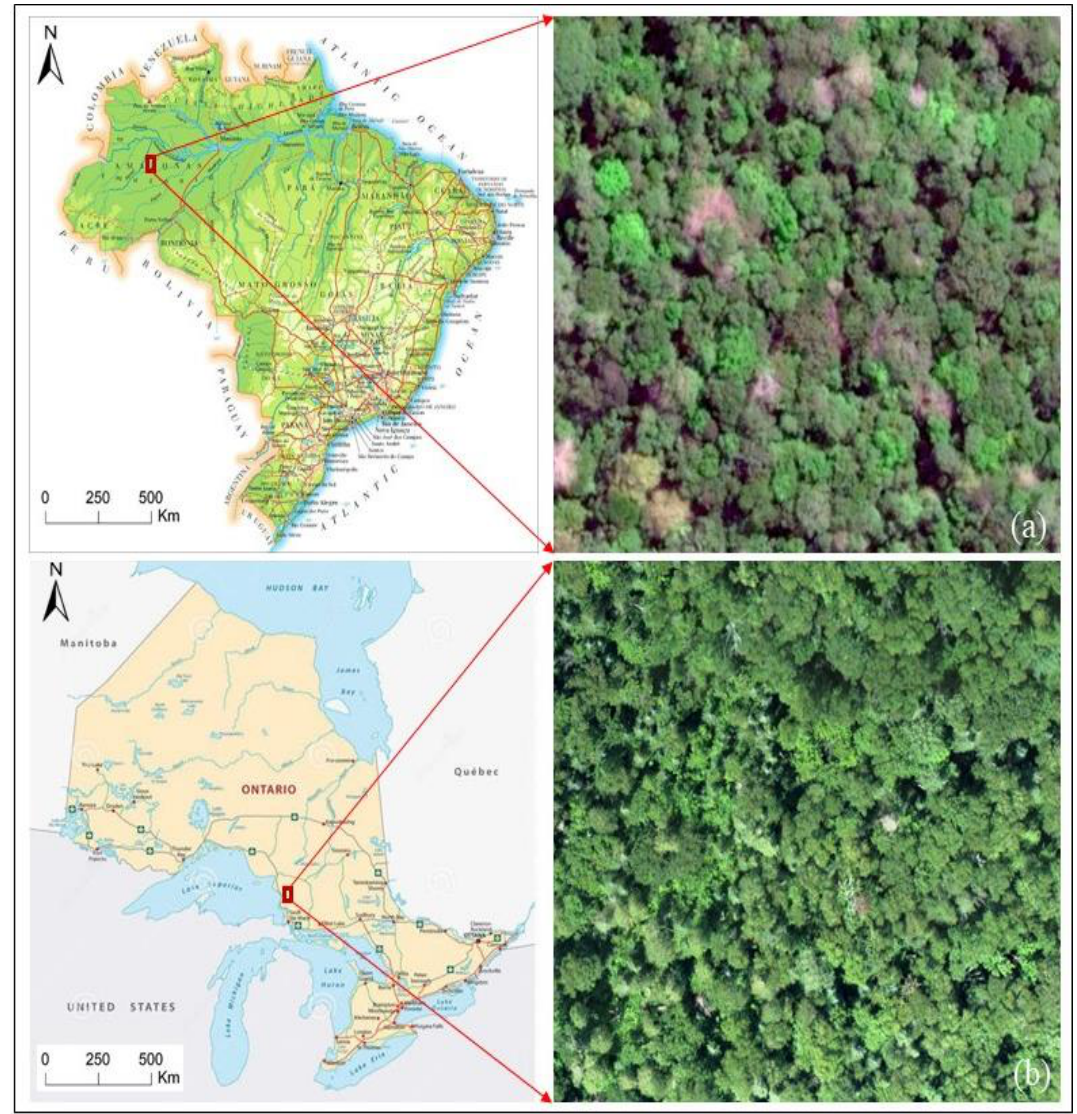
Figure 1. The locations of the two experimental plots. The rainforest ( a ) and the deciduous forest ( b ).